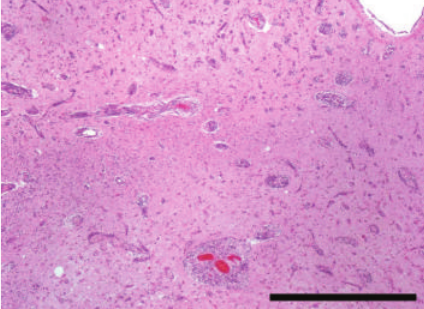
Figure 5: Perivascular wall tumor; right piriform lobe. The margins of the mass frequently have spindle cells predominantly arranged in whorls surrounding blood vessels infiltrating beyond the primary mass. H&E × 40. Bar = 1mm.